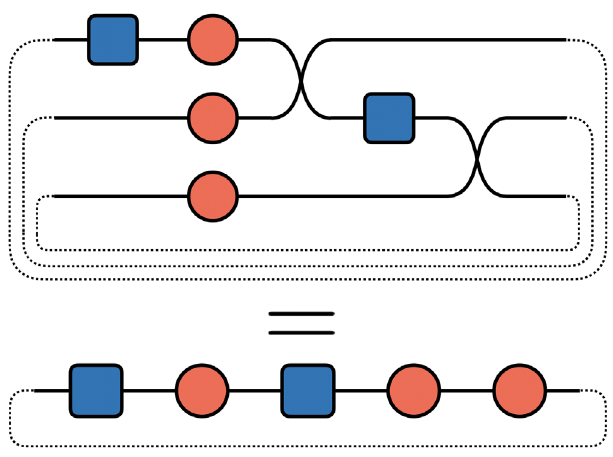
FIG. 12. A diagrammatic proof of Eq.